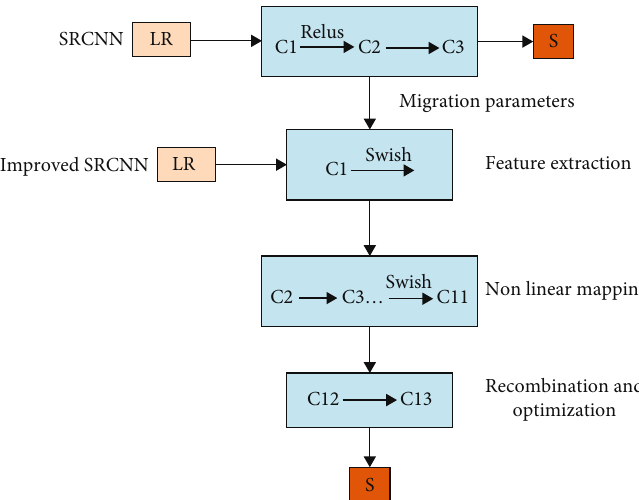
Figure 6: Improved SRCNN algorithm framework.